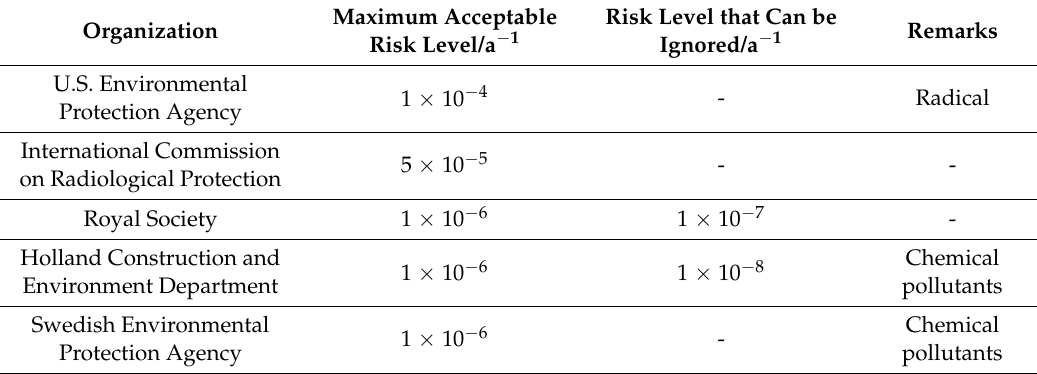
Table 3. The maximum risk acceptance risk level and negligible level of some organizations.